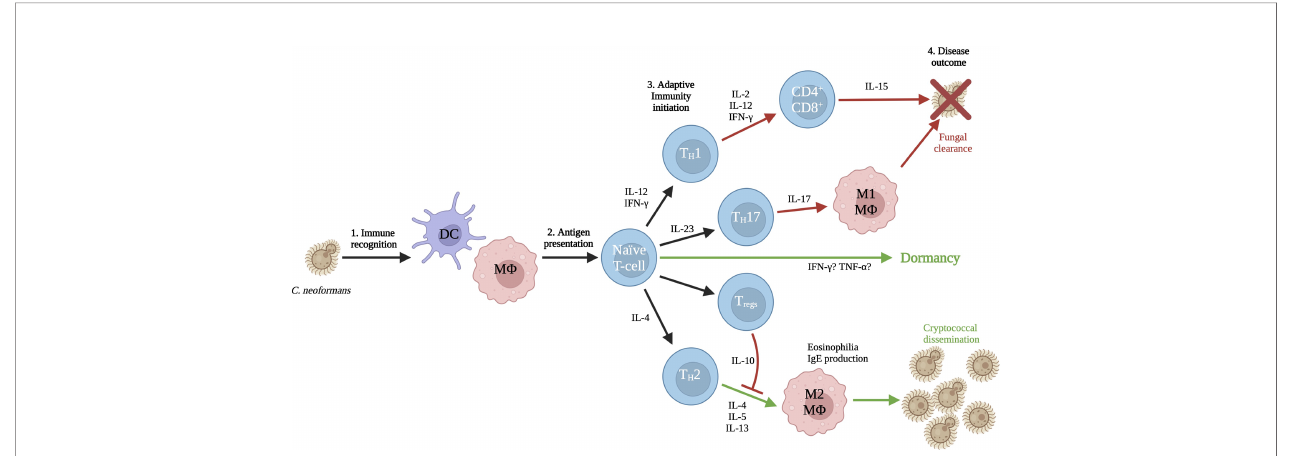
FIGURE 1 | Interactionwiththeimmunesystem.The fi rstcellstointeractwith C.neoformans aredendriticcellsandmacrophages,particularlyalveolarmacrophages.These antigenpresentingcellssoundthealarmtonaïveT-cells,whowillrespondbymountingeitheraprotectiveornon-protectiveresponsebasedontheinitiallocalcytokineenvironment. T-celldifferentiationleadstoeithertheincompatibleM1responsebymacrophagesthatresultsinclearanceoftheyeasts,orthecompatibleM2responsethatresultsindissemination oftheyeaststointeriorbodysites.Thecytokineresponsesandtriggersthatleadtodormancyarealsoasyetundeterminedandanimportantareaforfutureinvestigations.Figure adaptedfrom(MukaremeraandNielsen,2017)toshowpossiblelinksbetweenhost-pathogencommunicationanddormancy.CreatedwithBiorender.com.